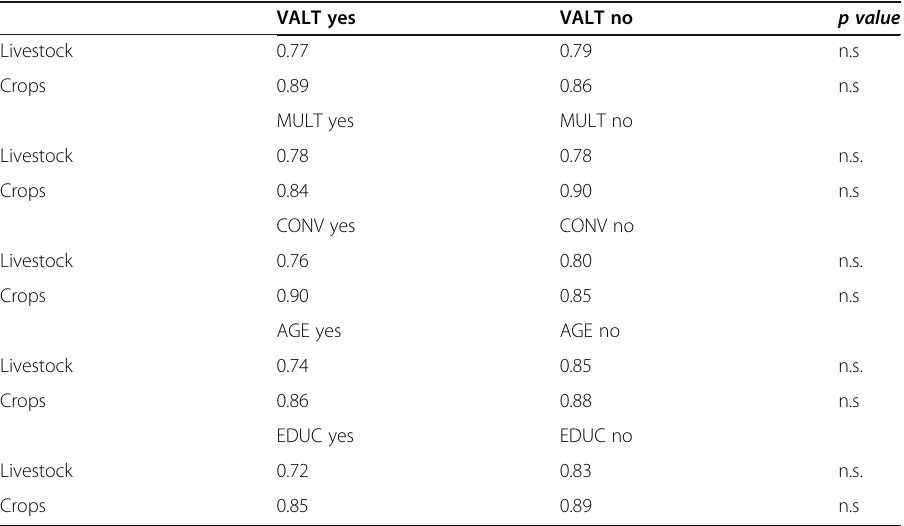
Table 7 t -test statistics for livestock and crops for different strategies of commercialization and for demographic variables; for the description of the code and the variables see Table